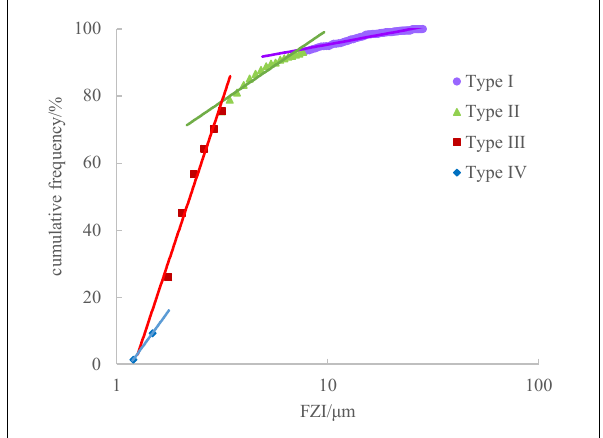
Figure 7. The cumulative frequency distribution of FZI in the granitic formation in No. 2 Gas Field. Table 2. Classification criteria for different flow units in low-permeability tight reservoirs of granitic formation in No. 2 Gas Field.